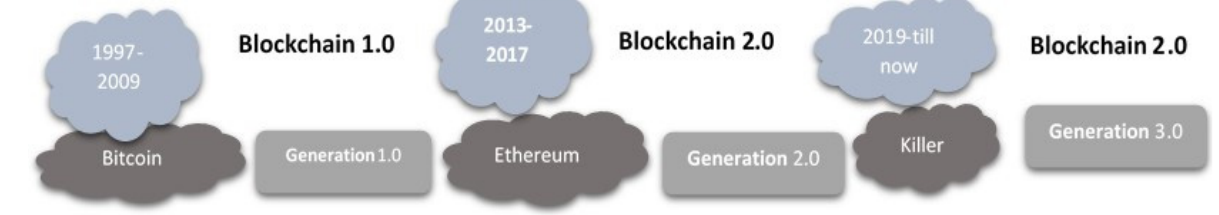
Figure 8. Uprising of Blockchain technology.